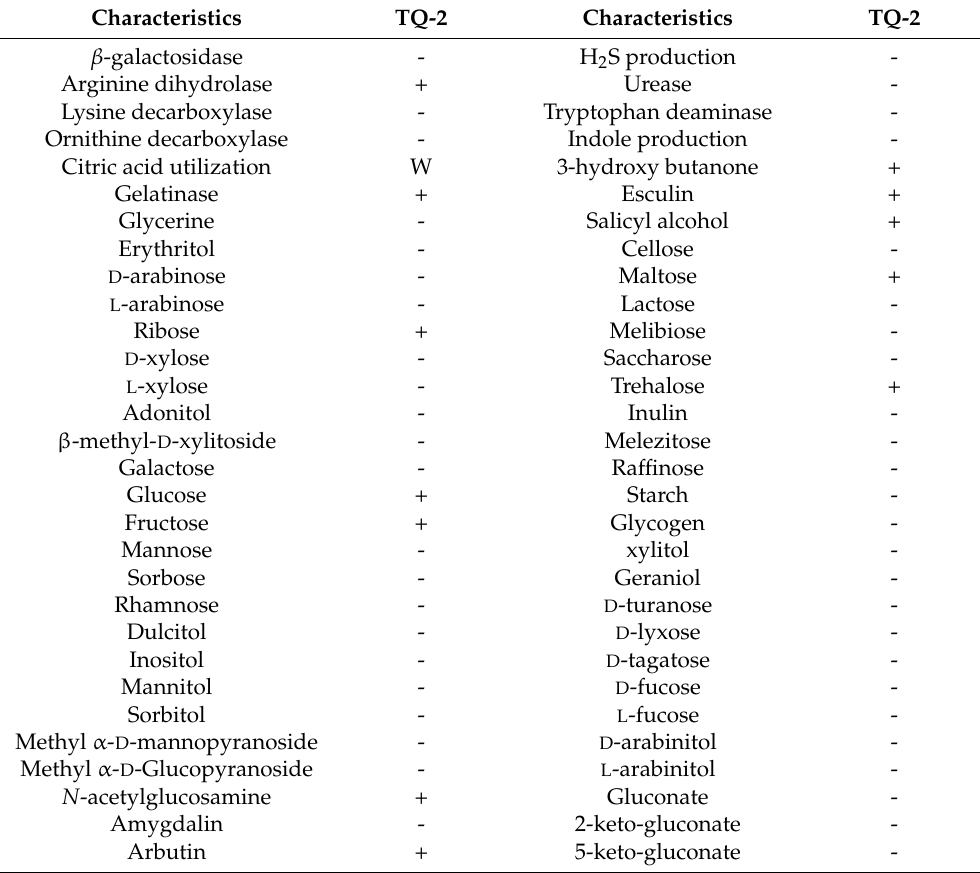
Table 1. Identification and phenotypic characteristics of TQ-2 strain.